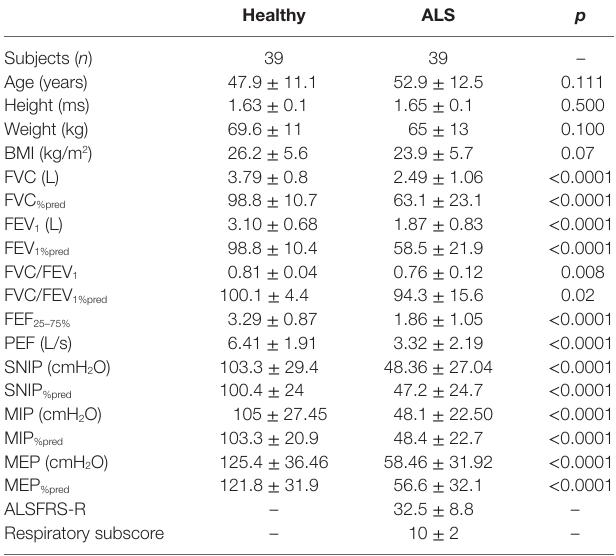
TaBle 1 | Characteristics of the subjects in relation to anthropometric data, absolute and predicted values of lung function, respiratory muscle strength, and functional